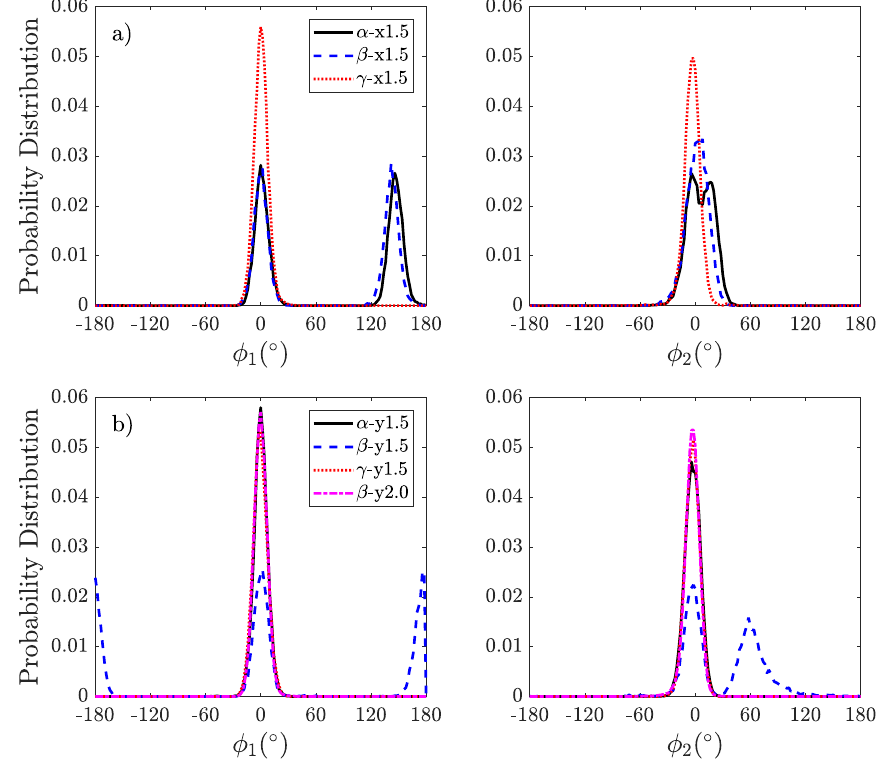
Figure 8. Relative orientation distributions of molecules in the new polymorphs obtained from initially α -, β -, and γ -glycine crystals when the e-field is applied in ( a ) x-dir and ( b ) y-dir. (V = 1.50 V/nm for all cases presented in this plot, except for the additional β -y2.0 distribution, in which case the strength of the applied e-field was 2.0